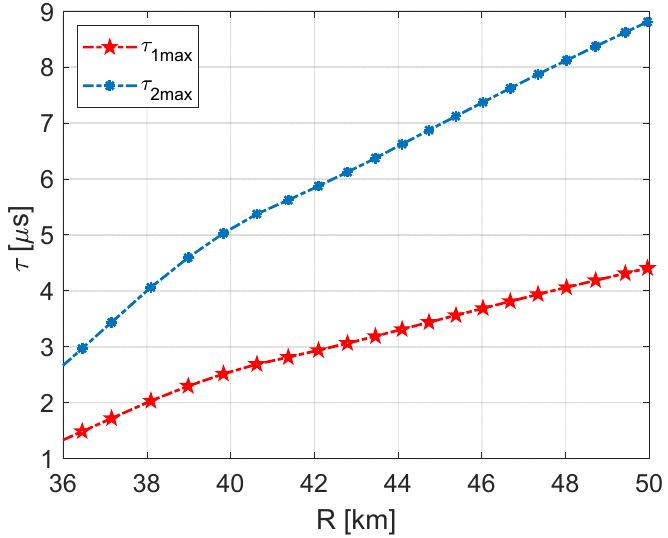
 and  at different positions when positive and negative Figure 9. The maximum delay Figure 9. The maximum delay τ 1max and τ 2max at different positions when positive and negative 1max 2max frequency shifts are used. frequency shifts are